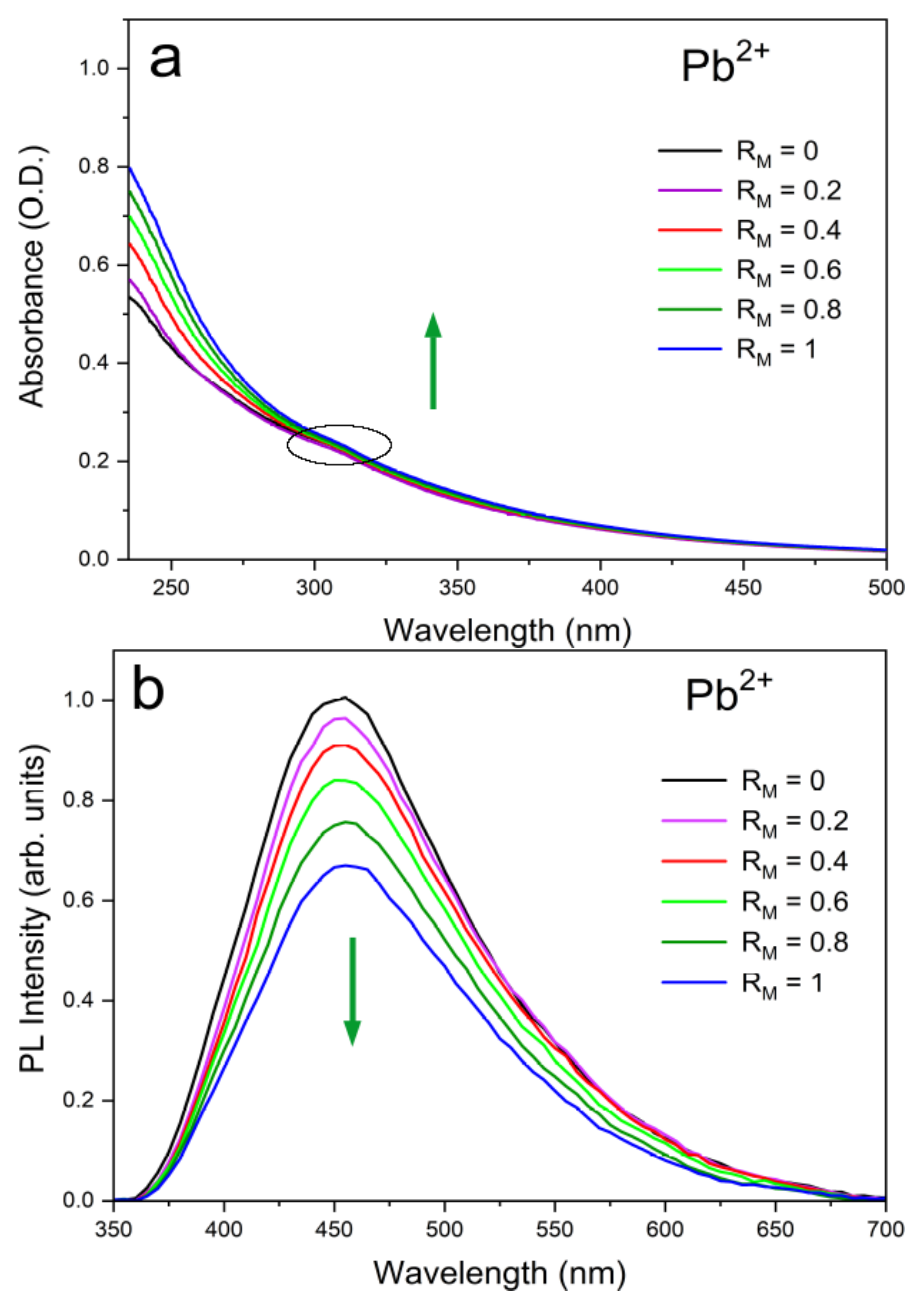
Figure 2. Experimental optical absorption ( a ) and emission ( b ) spectra of the aqueous suspension of UFQDs in the presence of Pb 2 + at different values of the ratio of the respective molar concentrations RM = [Pb 2 + ]/[UFQD]. A maximum decrease to 67% in the quantum yield was observed at RM =